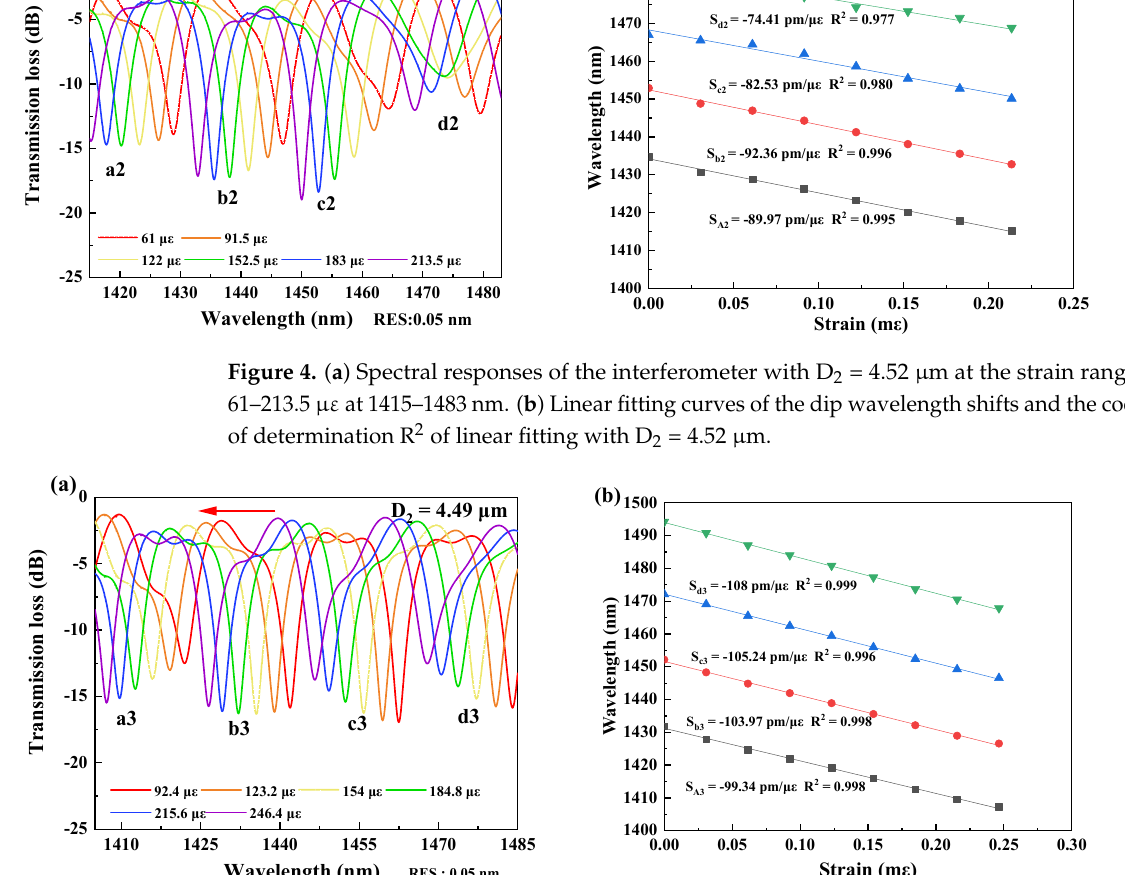
Figure 6. ( a ) Spectral responses of the interferometer with D 2 = 2.62 μm at the strain ranging over 122–213.5 με at 1513–1570 nm. ( b ) Linear fitting curves of the dip wavelength shifts and the coeffi- cients of determination R 2 of linear fitting with D 2 = 2.62 μm.